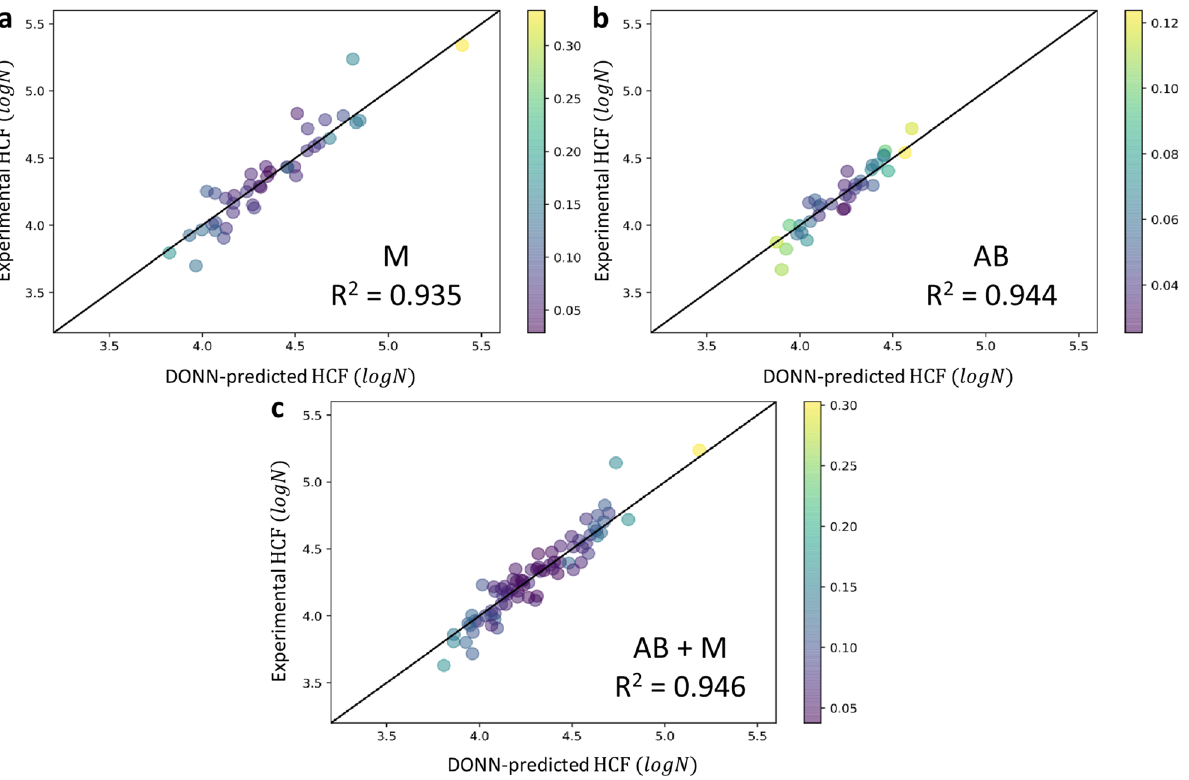
Figure 16. Pair plots between DONN predictions and experimental HCF in logN , with uncertainties being displayed in different colors for (a) AB, (b) M and (c) combined AB + M